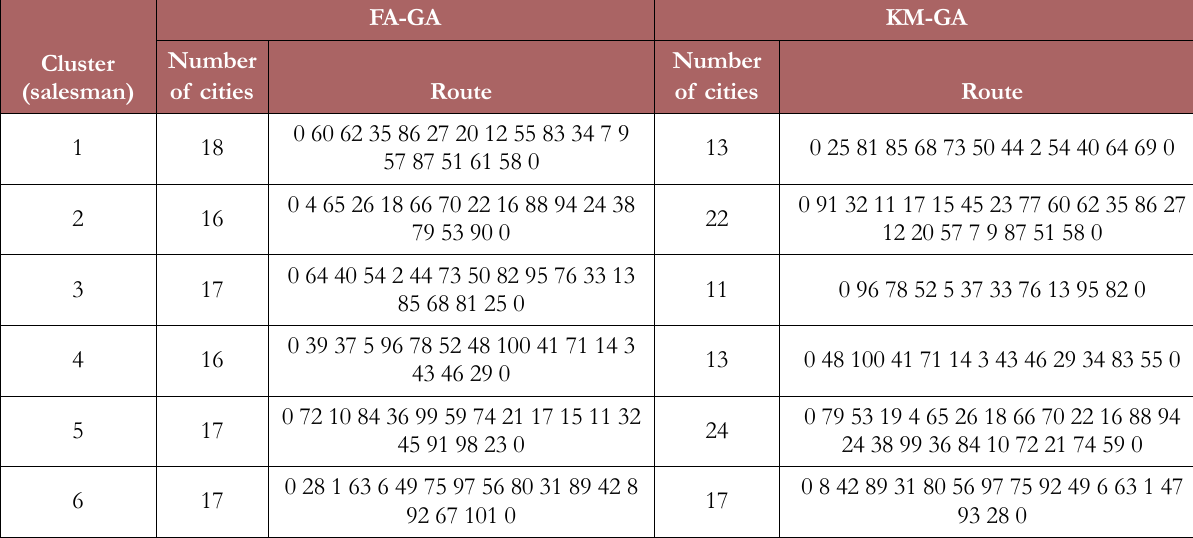
Table 8. Optimal routes for instance